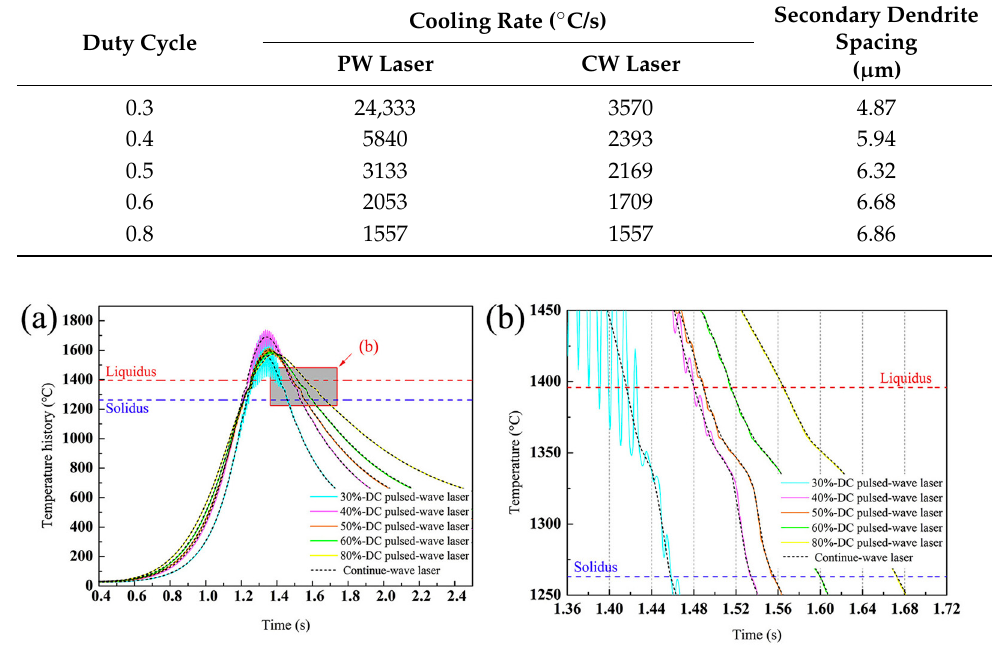
Cooling Rate ( ◦ C/s) Secondary Dendrite